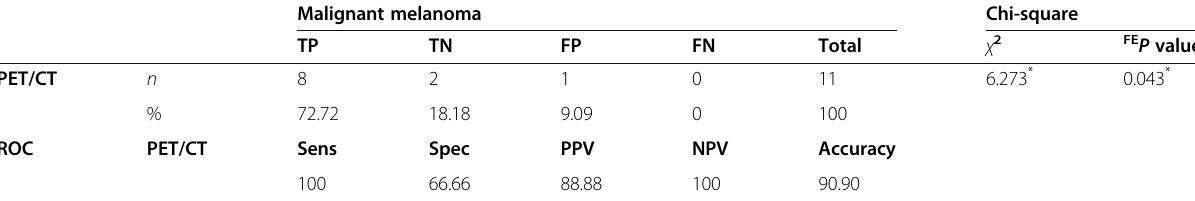
Table 4 Sensitivity (Sen), specificity (Spec), accuracy, PPV, and NPV of PET/CT in detection of recurrent disease in G2, n = 11 melanoma patients